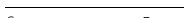
dataset, and the results are compared in the case of differ- ent data amounts in the source domain and target domain.